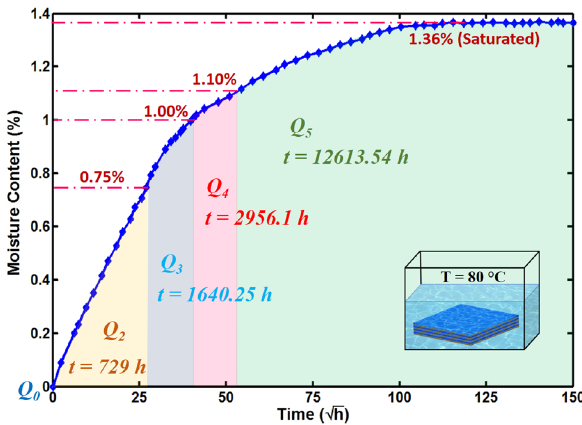
Figure 1. Water absorption behavior of quasi-isotropic composite plate at 80 °C.